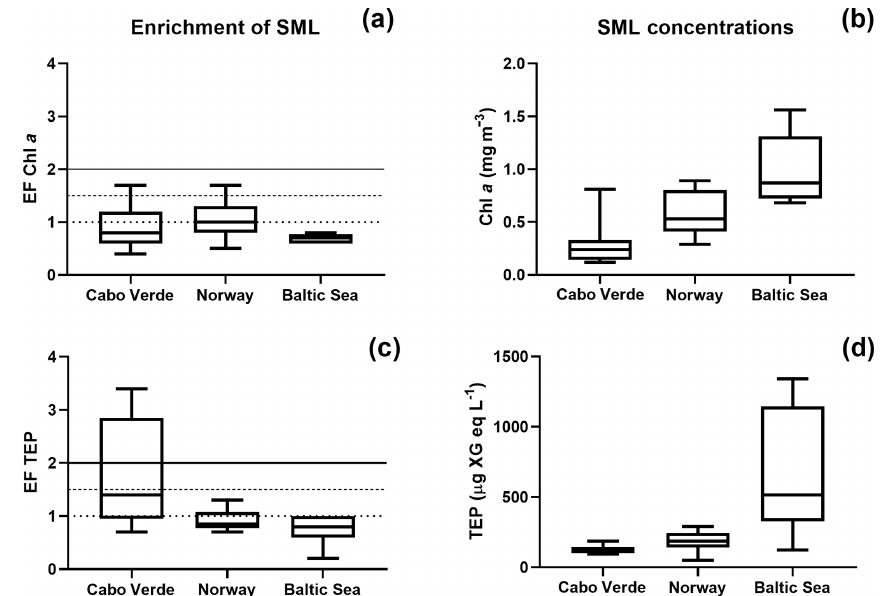
Figure 2. Regional comparison of enrichment and SML concentrations for Chl a (a, b) and TEPs (c, d) . The enrichment factor (EF) is given on the y axis for panels (a, c) and is given as the concentration in the SML over the concentration in the ULW. Horizontal lines are shown on panels (a, c) to distinguish varying levels of enrichment.